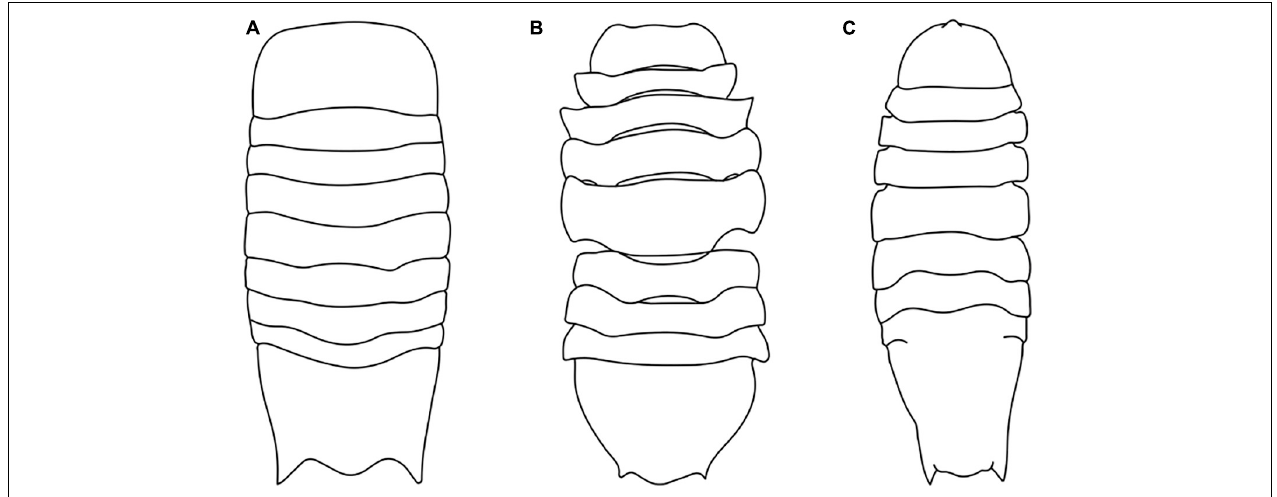
FIGURE 3 | Habitus drawing of Antennuloniscus (A) , Chauliodoniscus (B) , and Haploniscus (C) (Modified after Lincoln, 1985a,b; Brökeland and Wägele,